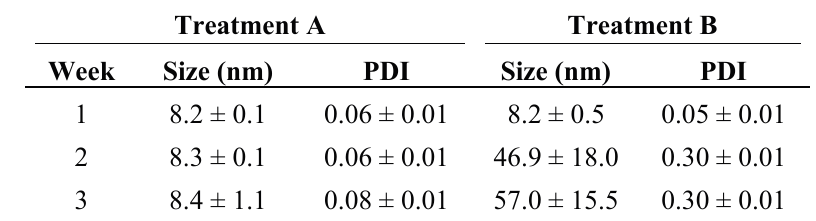
Table 1. Average size and PDI values as a function of time for biflorin micellar nanostructures stored under different temperature conditions.